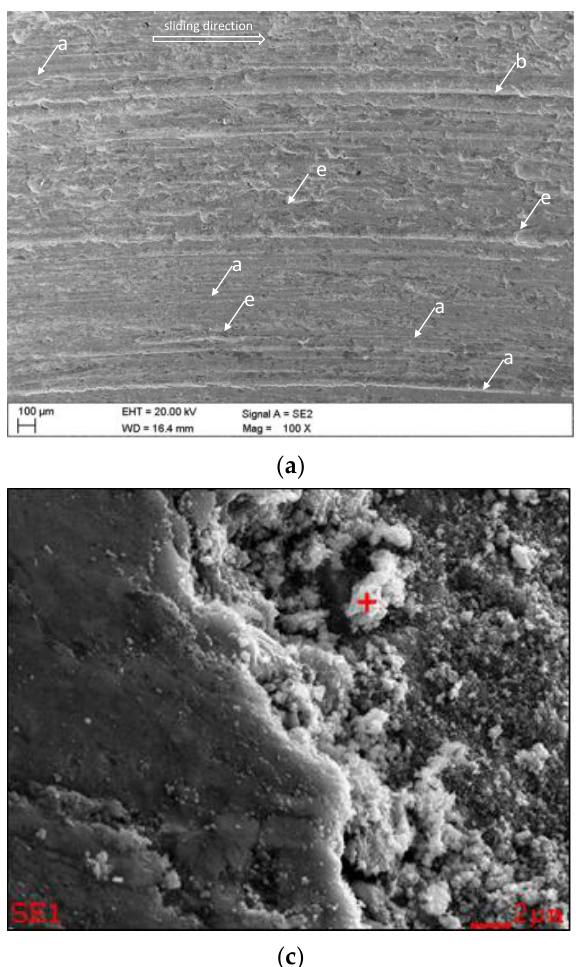
Figure 14. Time processes of volumetric wear u V of WRS_400_I steel for the discussed wear variants.